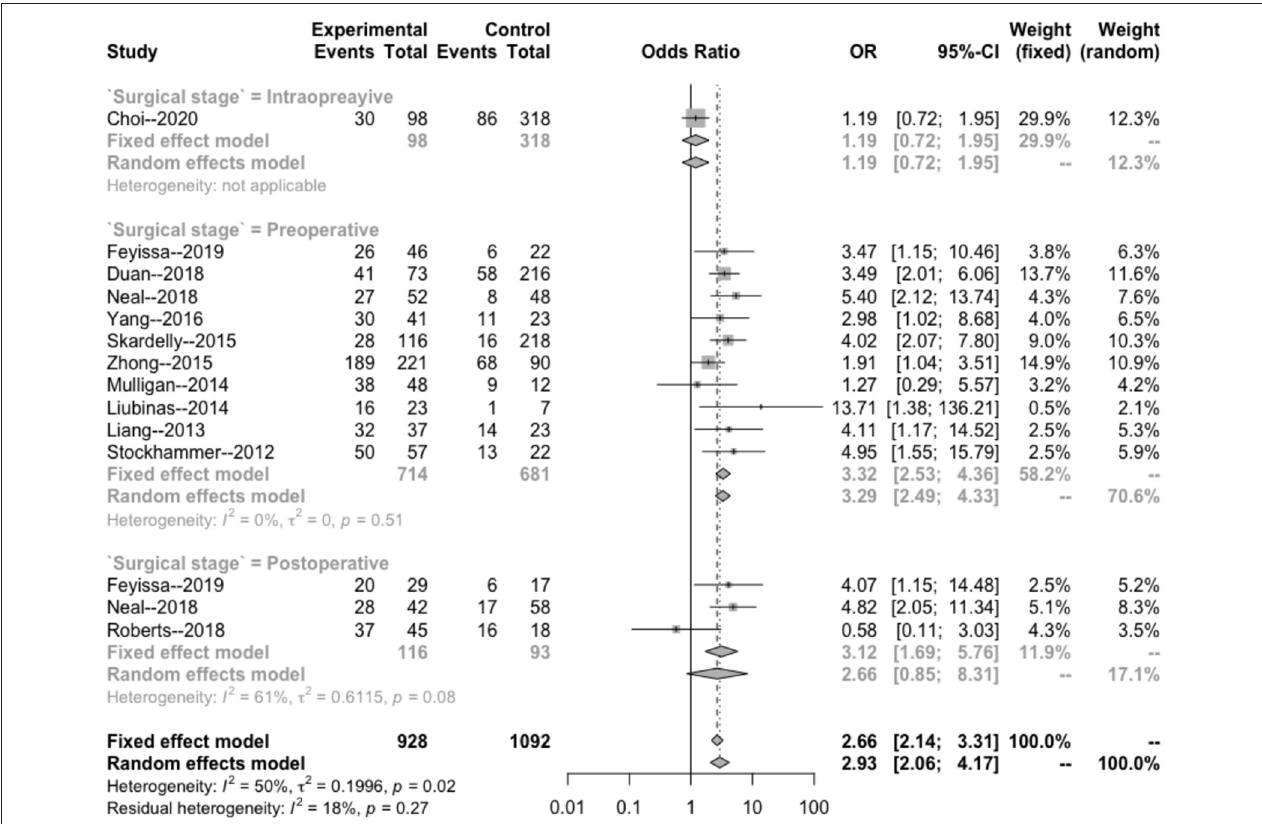
FIGURE 5 | Subgroup analysis of the relationship between IDH mutation and perioperative epilepsy. CI, confidence interval; IDH, isocitrate dehydrogenase; OR, odds ratio.